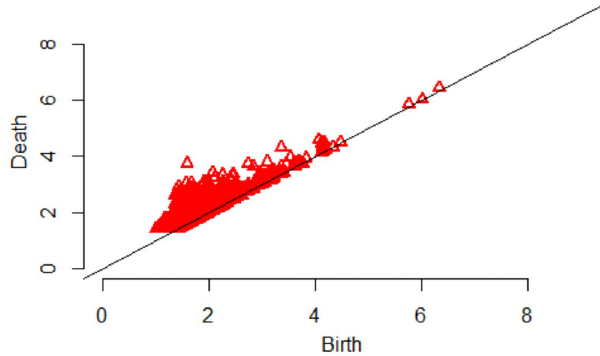
Fig 8. A persistence diagram at one time